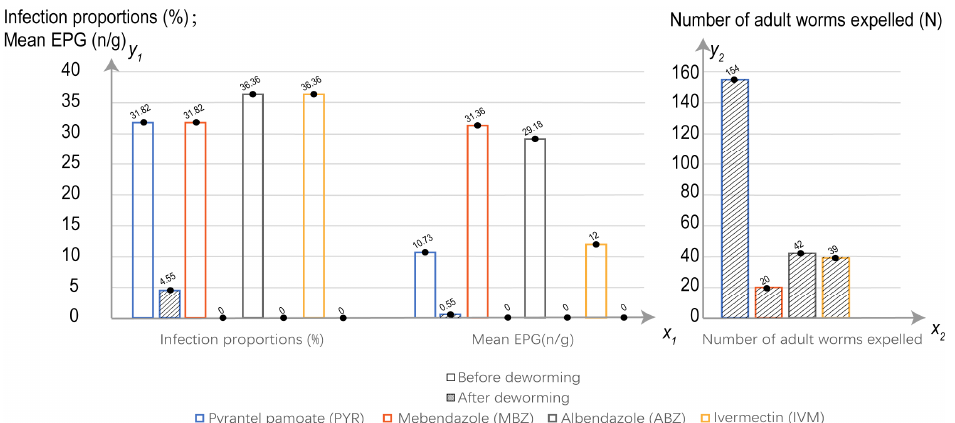
Animals 2023 , 13 , x FOR PEER REVIEW Figure 1. Infection rate, mean EPG, and number of adult worms. Figure 1. Infection rate, mean EPG, and number of adult worms.